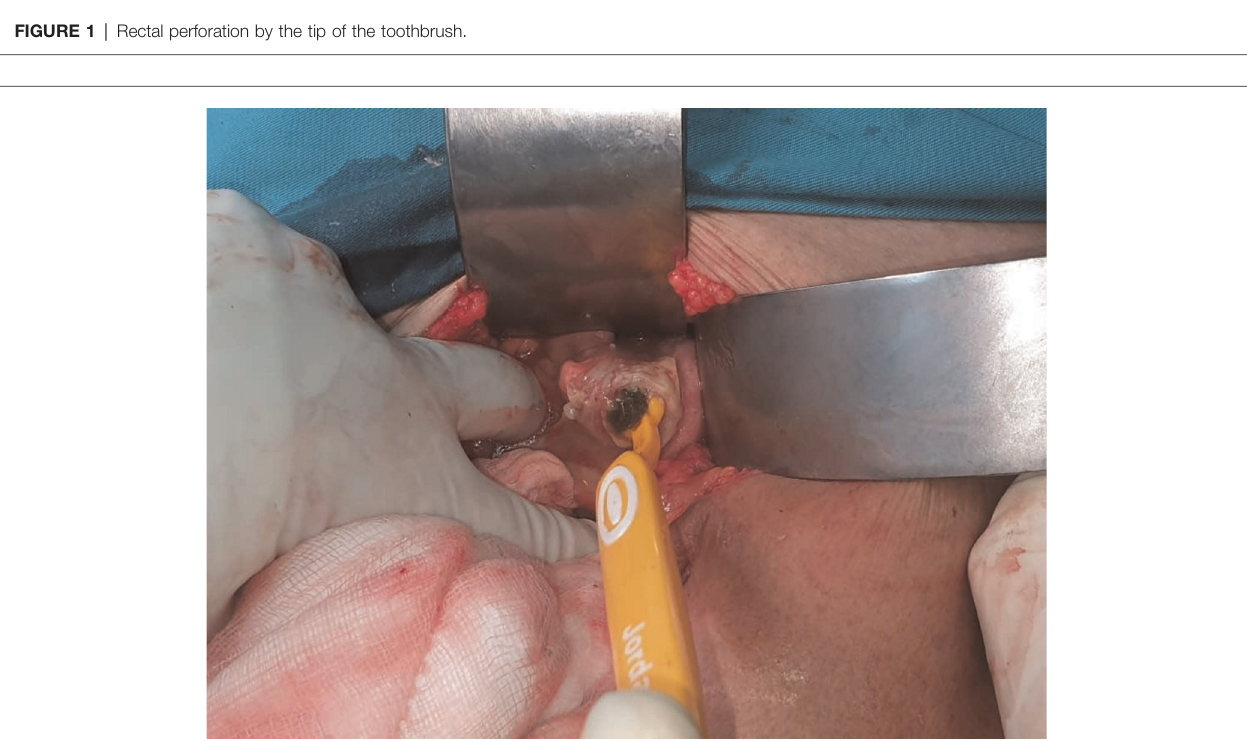
FIGURE 2 | Extraction of the toothbrush from the